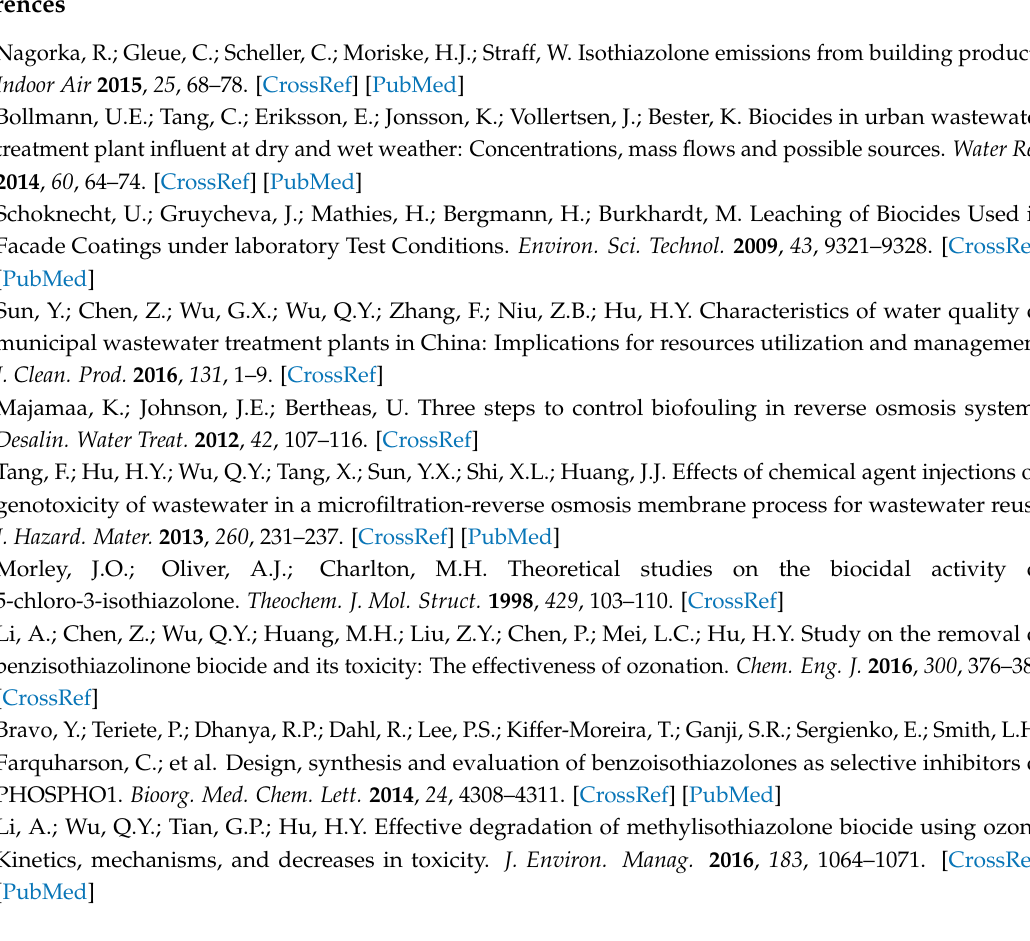
Figure S1: Effect of adsorption time on BIT adsorption amounts, Table S1: General properties of the four